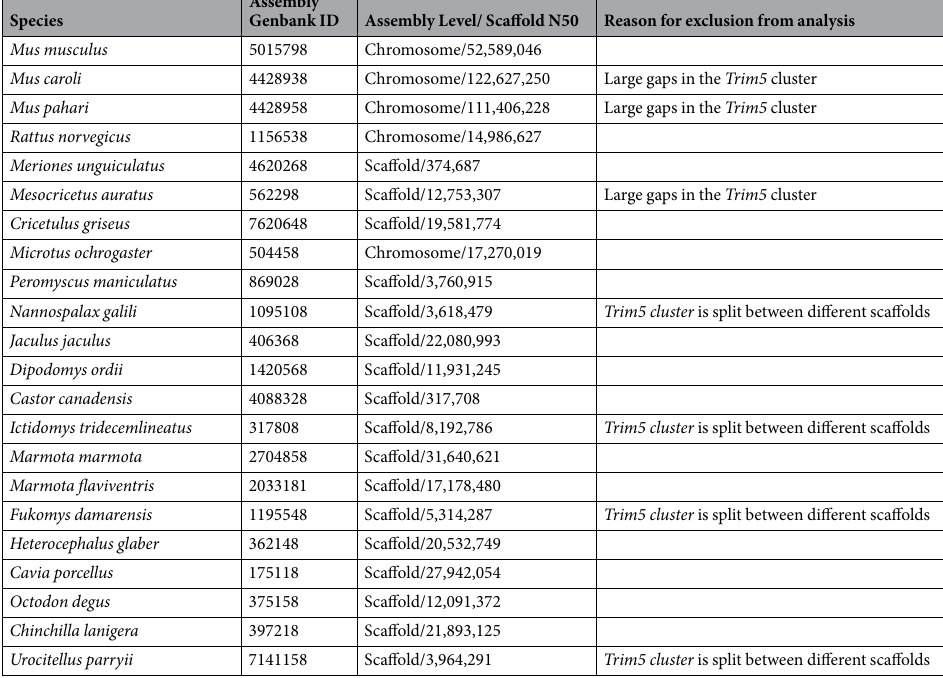
Trim5 cluster is split between different scaffolds